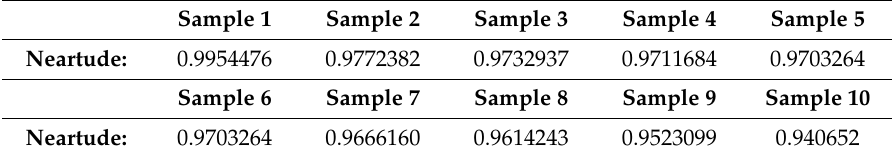
Table 4. The quantitative degrees of similarity between the samples and the evaluated